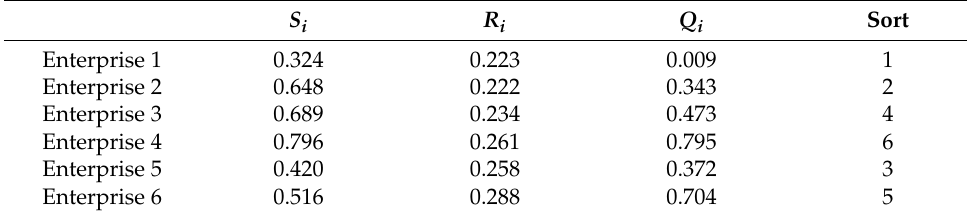
Table 10. Values of S i , R i , and Q i . S i R i Q